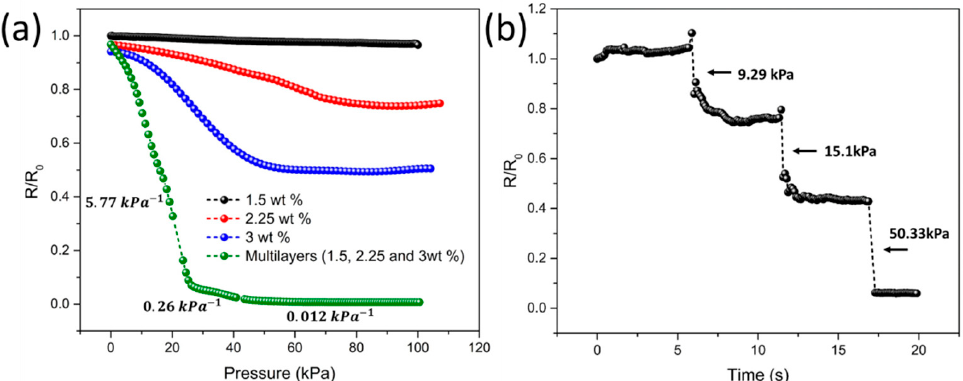
Figure 2. ( a ) Enhanced pressure-sensing performance of a multilayer composite with modulus gradient compared to a single-layer composite ( b ) Real-time pressure monitoring of composites for applied step loading (pressure values of 9.29 kPa, 15.1 kPa, and 50.33 kPa).